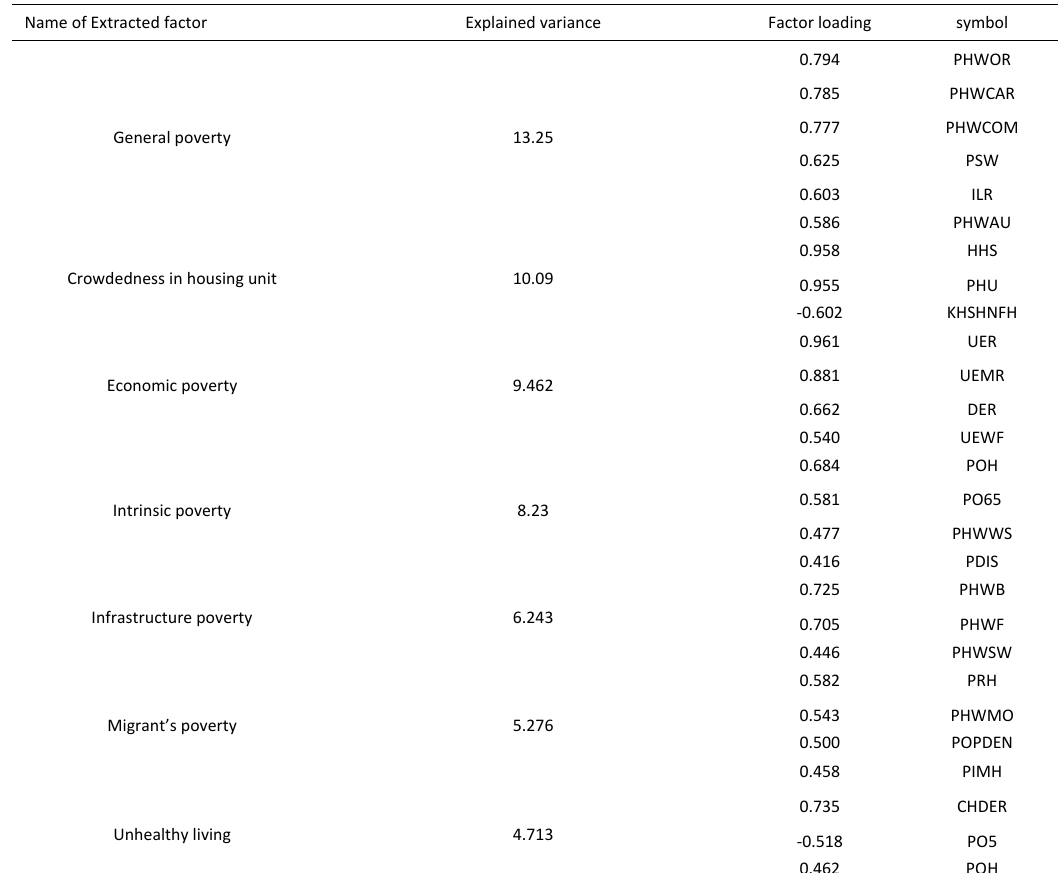
Table 2. Factors explaining poverty in Isfahan Metropolis Table 2: Factors explaining poverty in Isfahan Name of Extracted factor